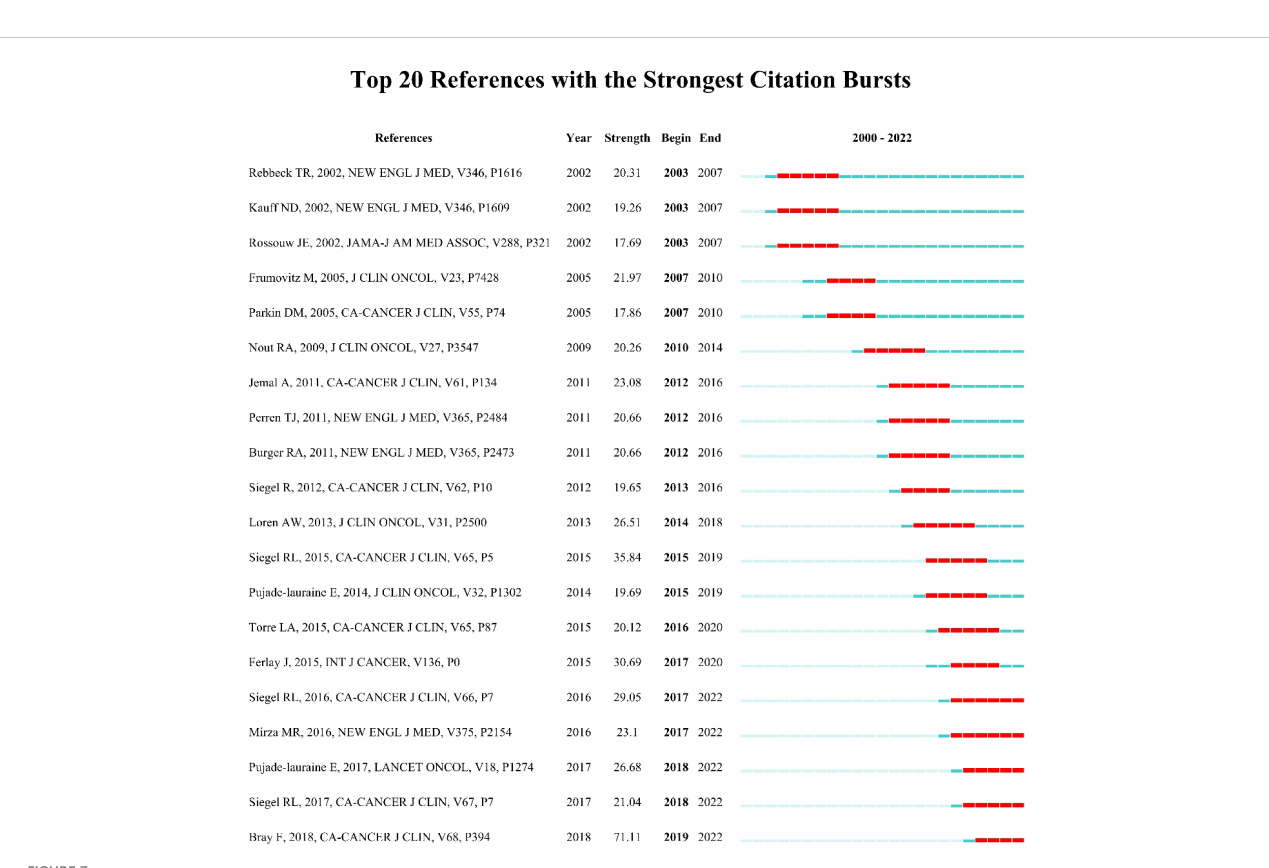
FIGURE 7 Top 20 references with the strongest citation